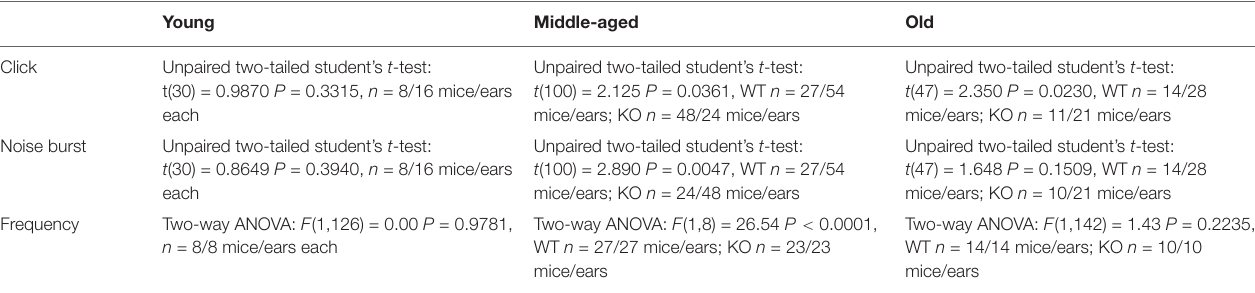
TABLE 2 | Table of